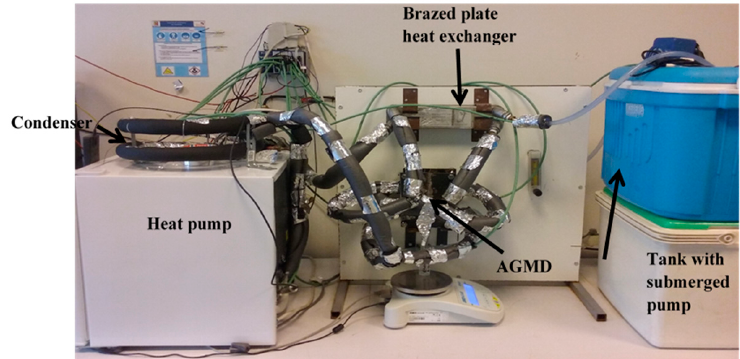
Figure 6. Photograph of the heat pump prototype coupled to the AGMD unit.